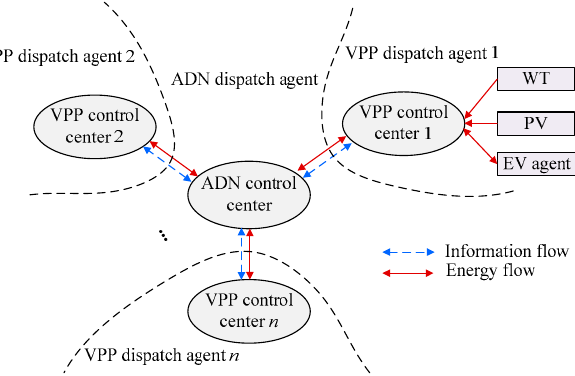
Figure 1. Interaction framework of VPPs and ADN.